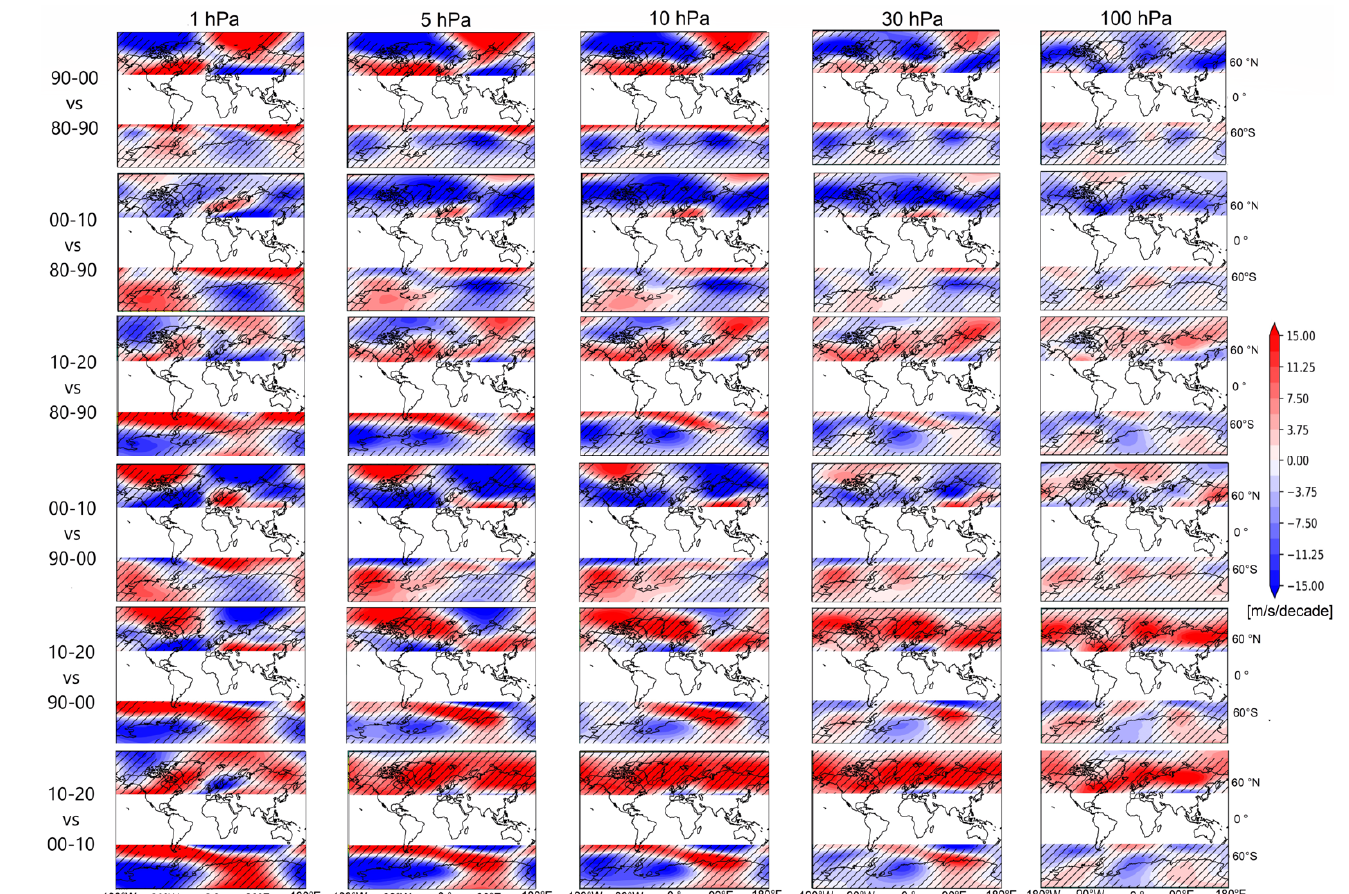
Figure 9. Difference of zonal wind trend (m/s) between decades for 1, 5, 10, 30 and 100 hPa using ERA5 reanalysis.